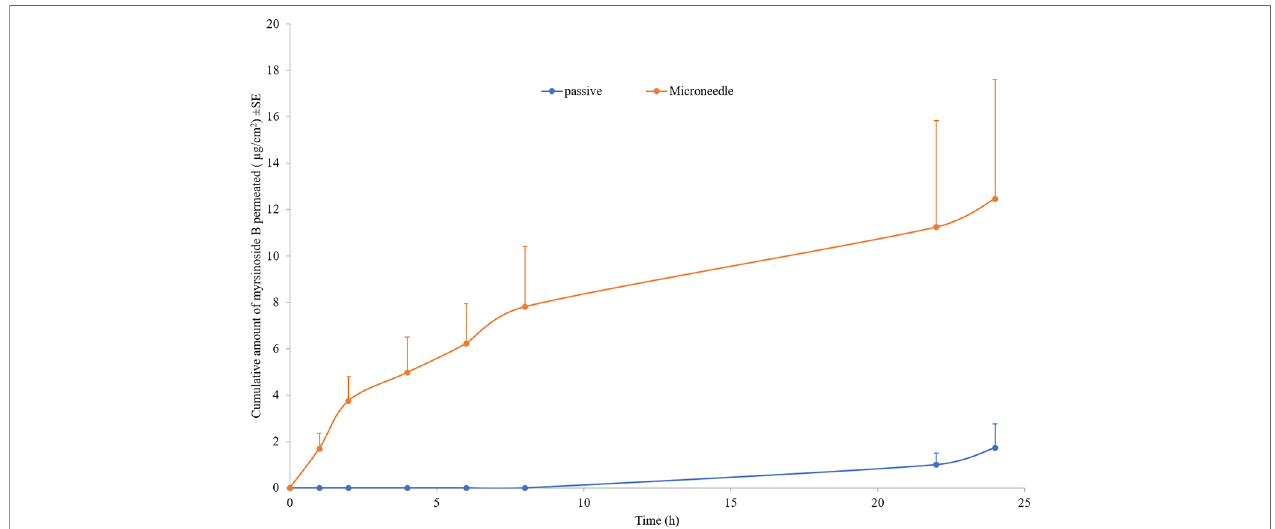
FIGURE 2 | Cumulative quantities of permeated myrsinoside B for the maltose microneedle treated skin compared to passive delivery (µg/cm 2 + SE, n ≥ 3). Maltose microneedle treatment signi fi cantly increases the quantity of myrsinoside B permeated and reduces lag time (n ≥ 3, Student ’ s t-test p < 0.05 indicates signi fi cant